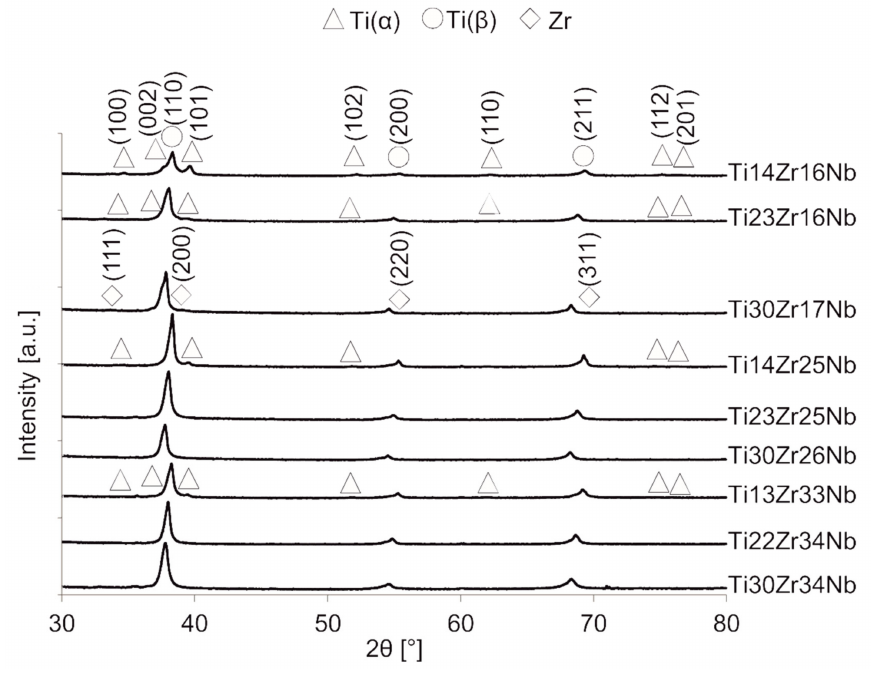
Figure 4. XRD spectra of bulk Ti-Zr-Nb specimens sintered at 750 ◦ C.